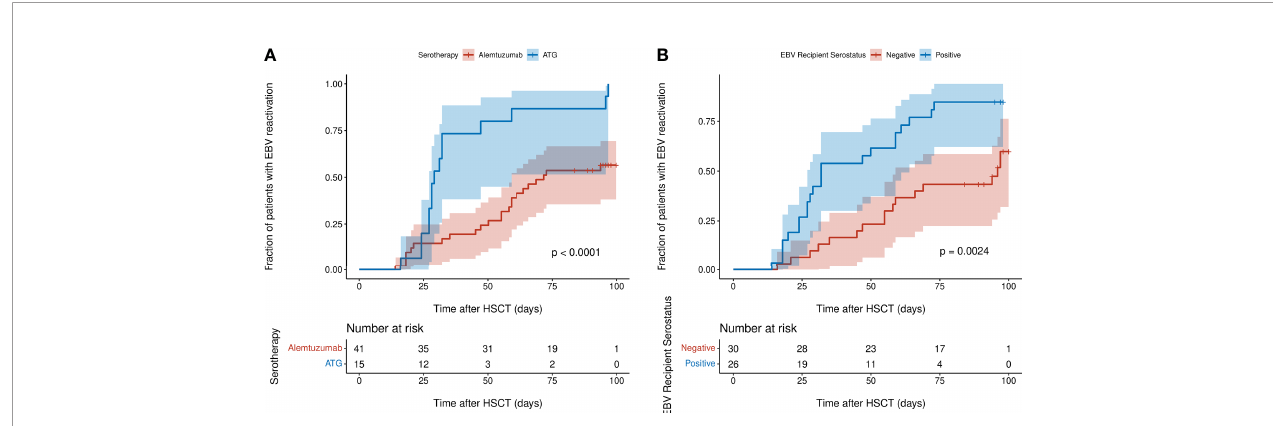
FIGURE 4 | Kaplan-Meier curves of cumulative fraction of patients with EBV reactivation in fi rst 100 days post-HSCT strati fi ed by: (A) type of serotherapy (ATG or alemtuzumab) (B) EBV serostatus of recipient (negative or positive). P values were calculated using the log-rank test and denote the difference between the two subgroups. Shaded regions show 95% con fi dence